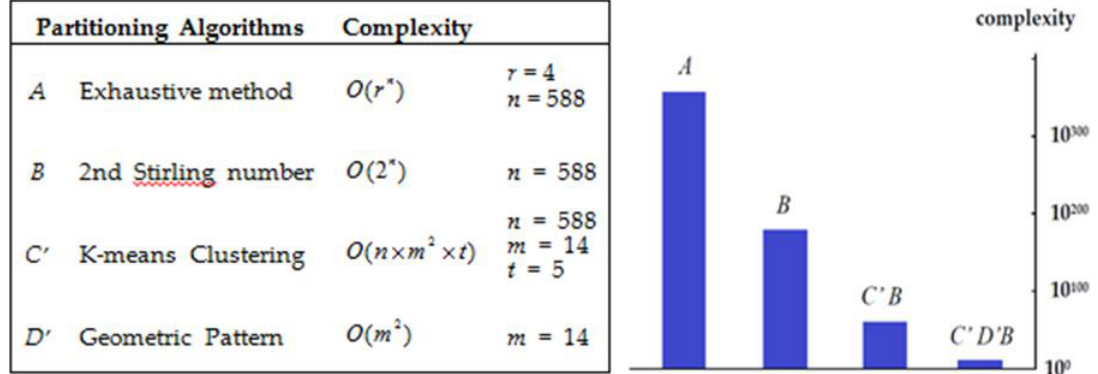
Figure 9. Experimental complexities of individual and combined methods used in this study.